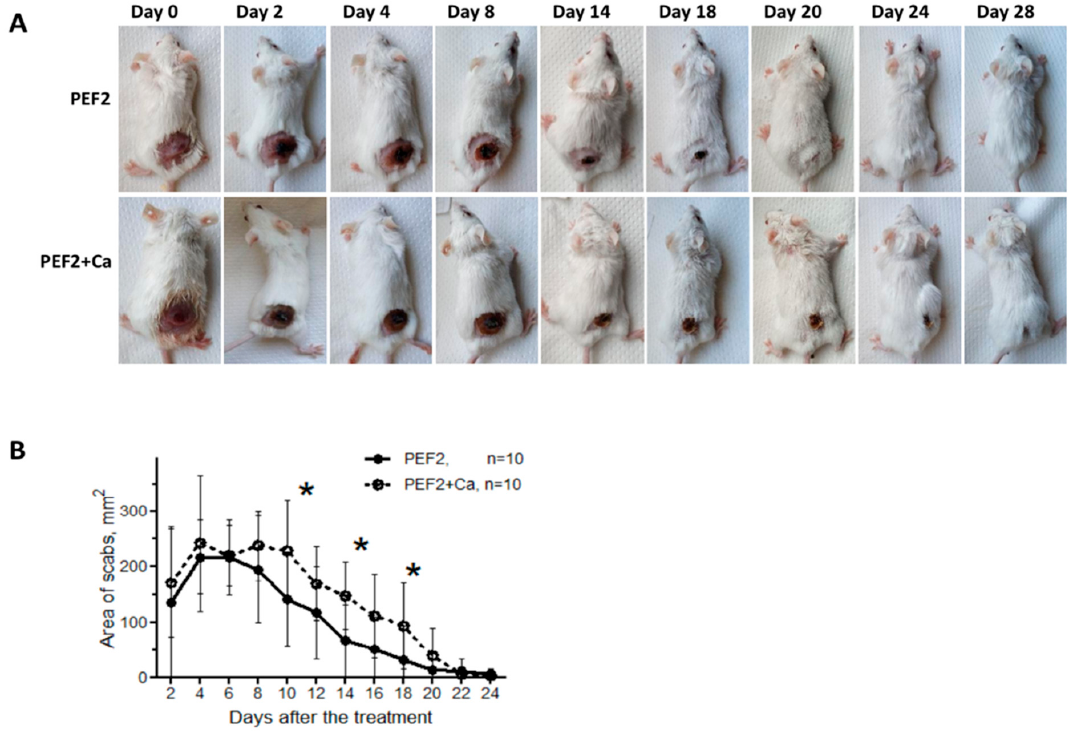
Figure 2. The changes in scab area depending on the treatment, where ( A ) representative images post-treatment; ( B ) dynamics of scab area; PEF2 protocol—12 kV / cm × 500 ns × 500 treatment was used separately and in combination with CaCl 2 . Asterisk (*) indicates significant differences according to Mann Whitney test ( p < 0.005) between the mice